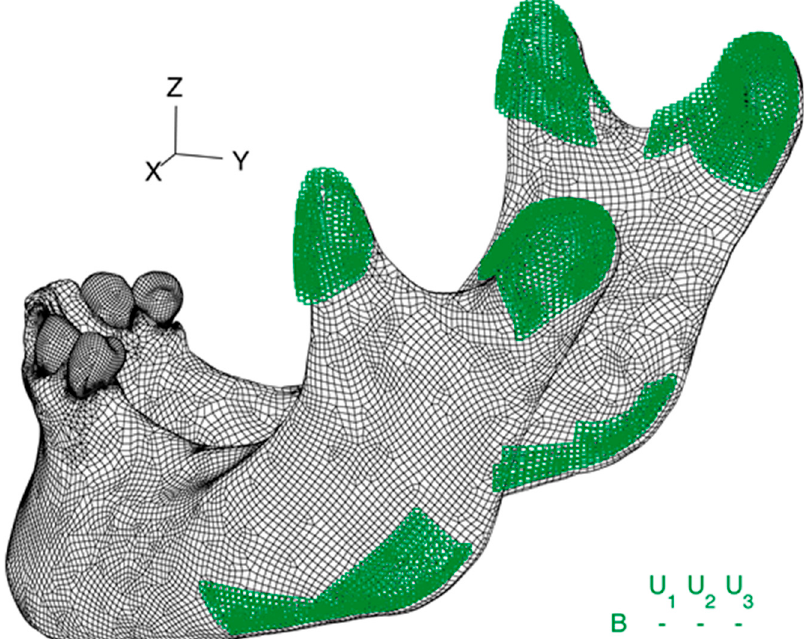
Figure 1. Boundary conditions applied to the model as all degrees of freedom fixity of the nodes located at the theoretical insertion of the mastication muscles masseter, middle temporalis and medial pterygoid, as well as complete fixity of the condyles.